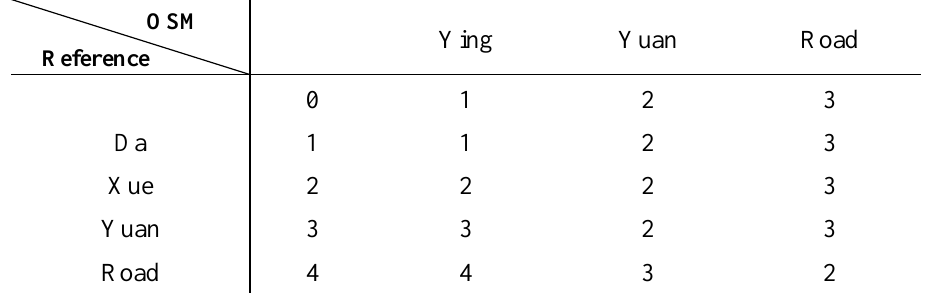
Table 1. An example for calculating the Edit distance between two road names. OSM Ying Yuan Road Reference 0 1 2 3